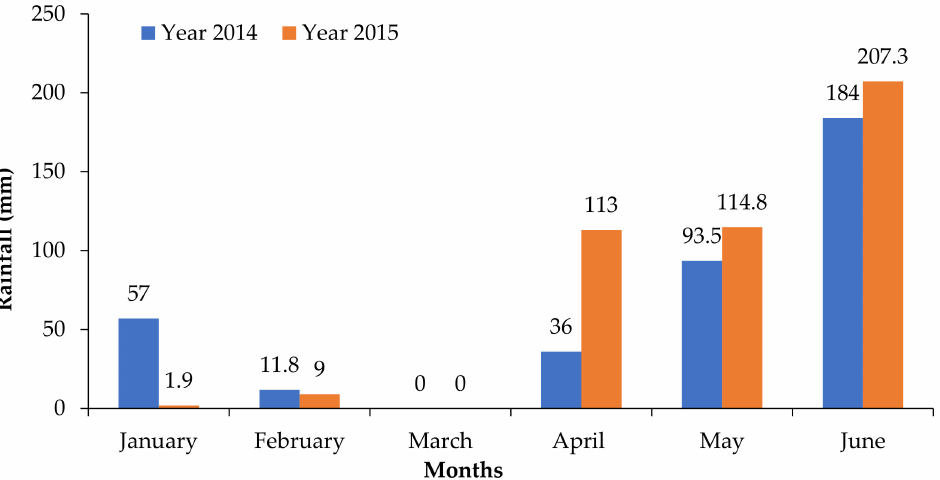
Figure 2. Monthly rainfall distribution pattern during the period of experimentation; values above bars denote the amount of total rainfall (mm).